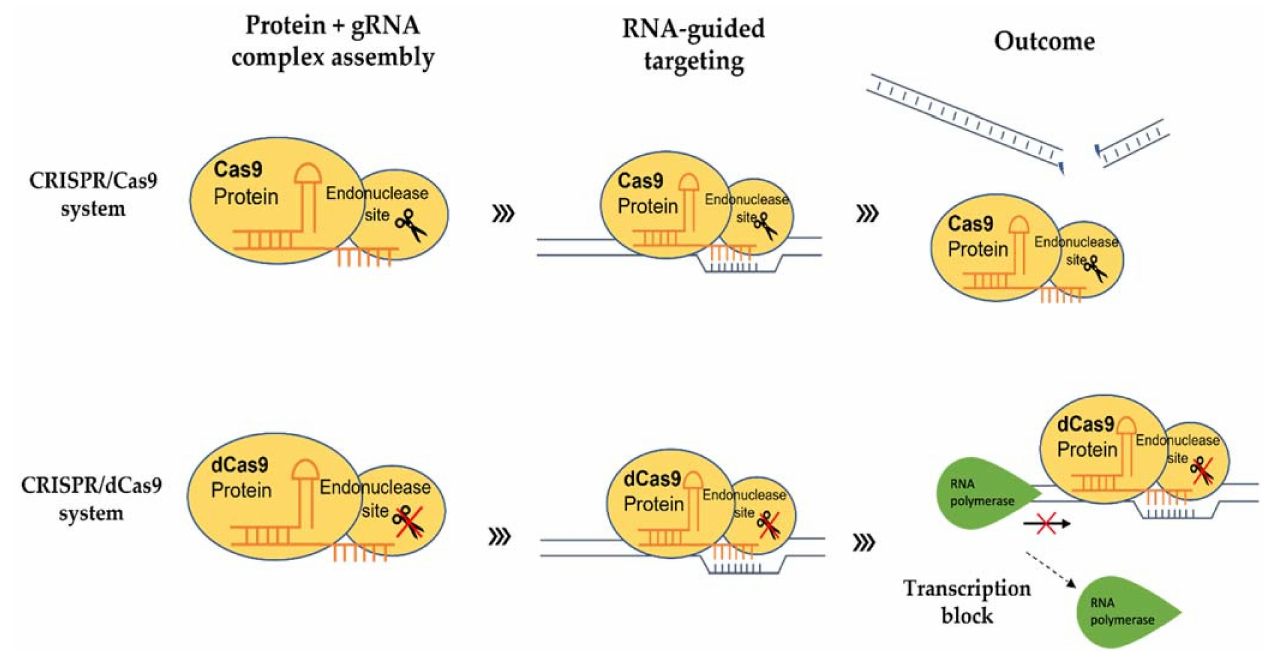
Figure 2. Schematic diagram showing the difference between the CRISPR/Cas9 system and the CRISPR/dCas9 system utilizing Cas9 and deactivated Cas9 (dCas9),